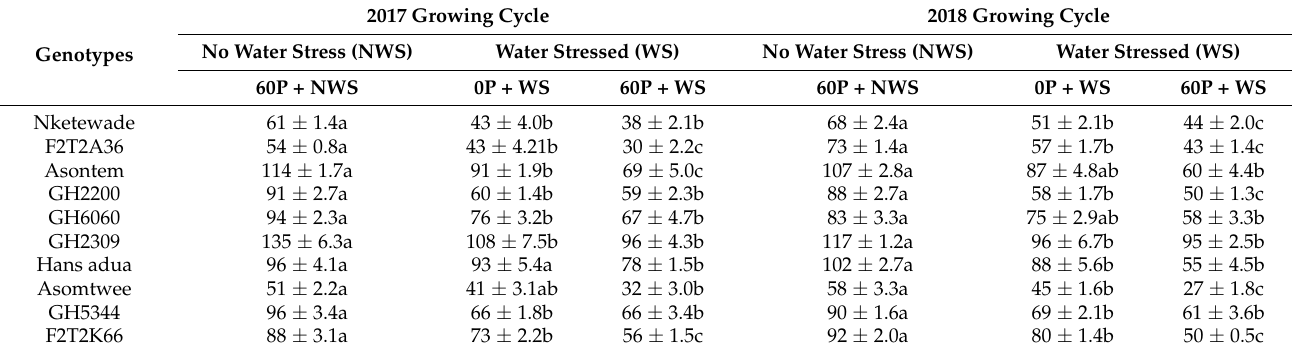
Table 4. Measurements of leaf greenness of cowpea genotypes using SPAD meter after imposition of first stress at the vegetative stage for 2017 and 2018 growing periods. Values showing the same letters indicate no significant differences between genotypes within individual water and phosphorus treatments at p ≤